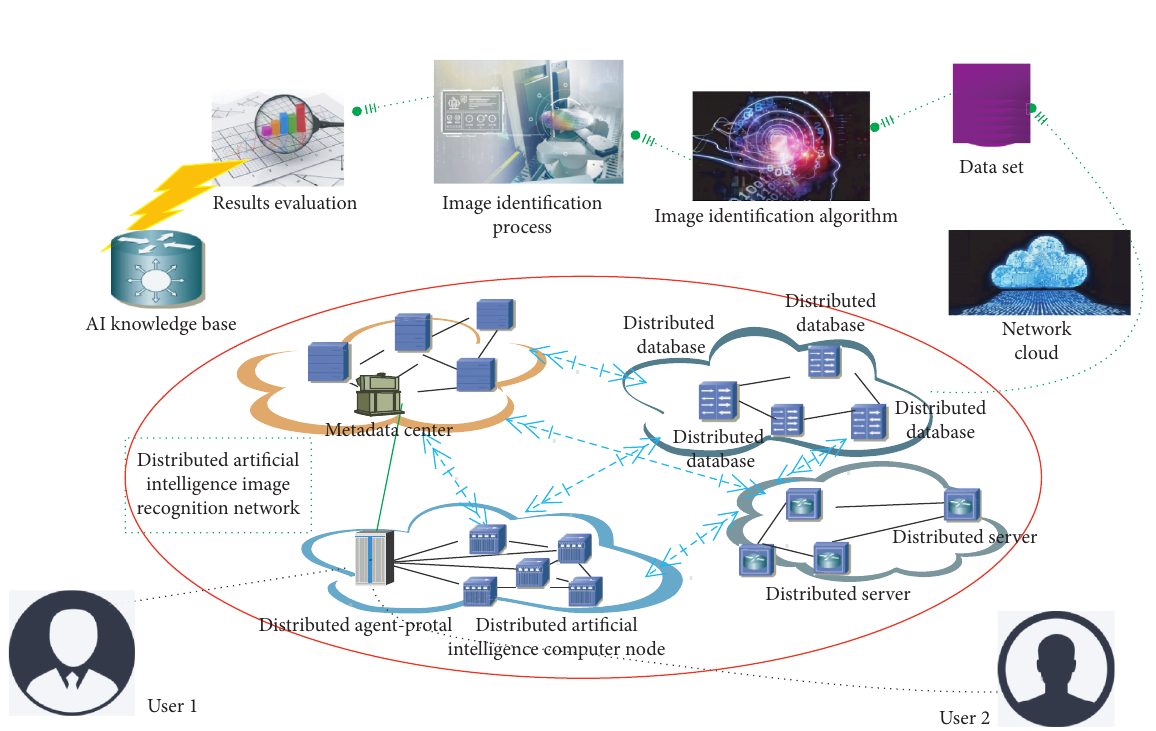
Figure 2: Schematic diagram of the interactive mode of distributed artificial intelligence image recognition.